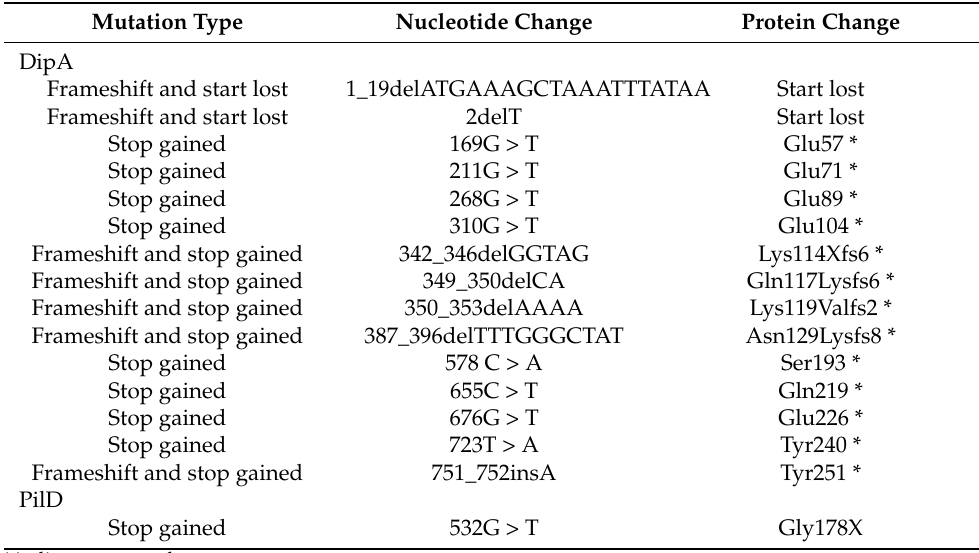
Table 2. Description of dipA and pilD mutations found in sequenced resazurin-resistant (Rzr) F. tularensis LVS isolates.